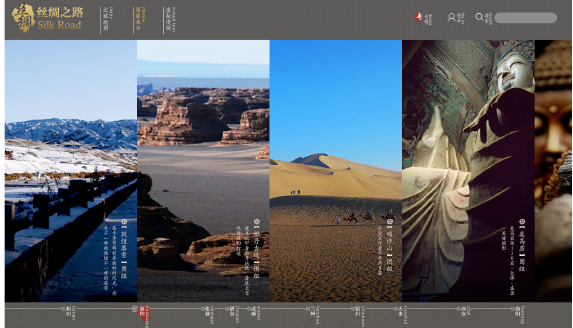
Figure 5: Example on interface design for Interactive graphics of the